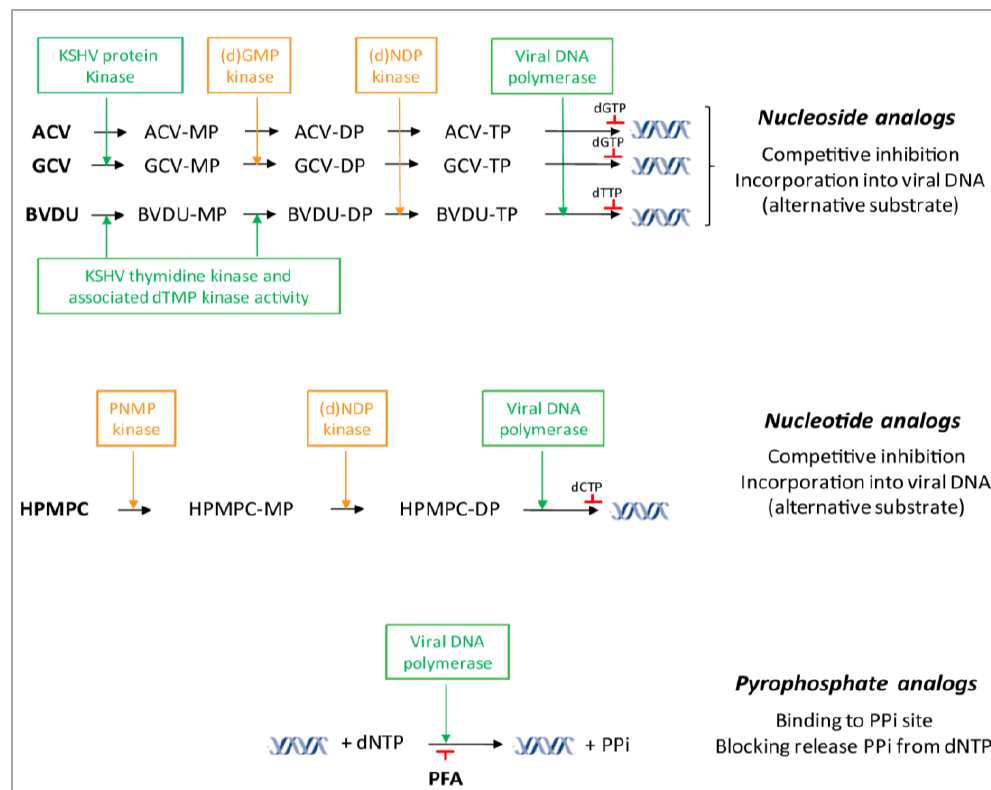
Figure 2. Mechanism of action of viral DNA polymerase inhibitors against KSHV replication. Nucleoside analogs require three phosphorylation steps to become